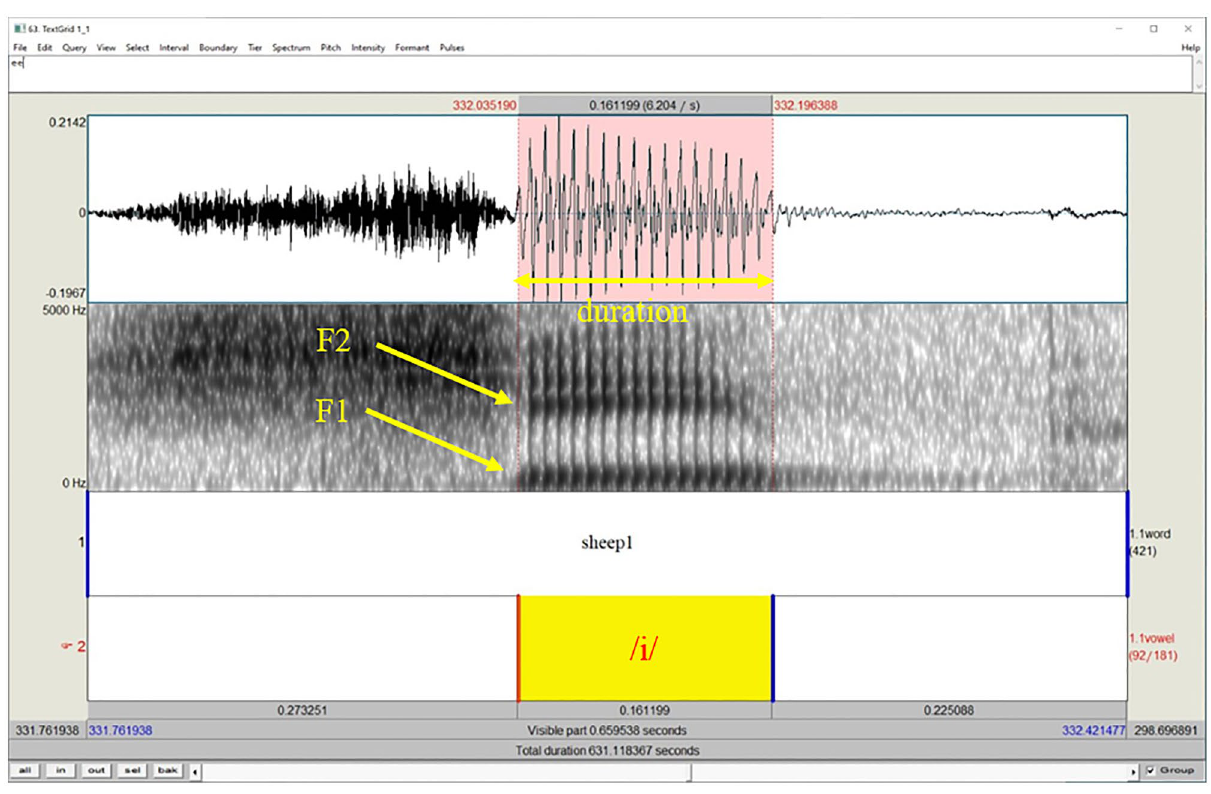
Figure 1. Example of a spectrogram showing the spectral and the temporal properties of the vowel /i/ embedded in